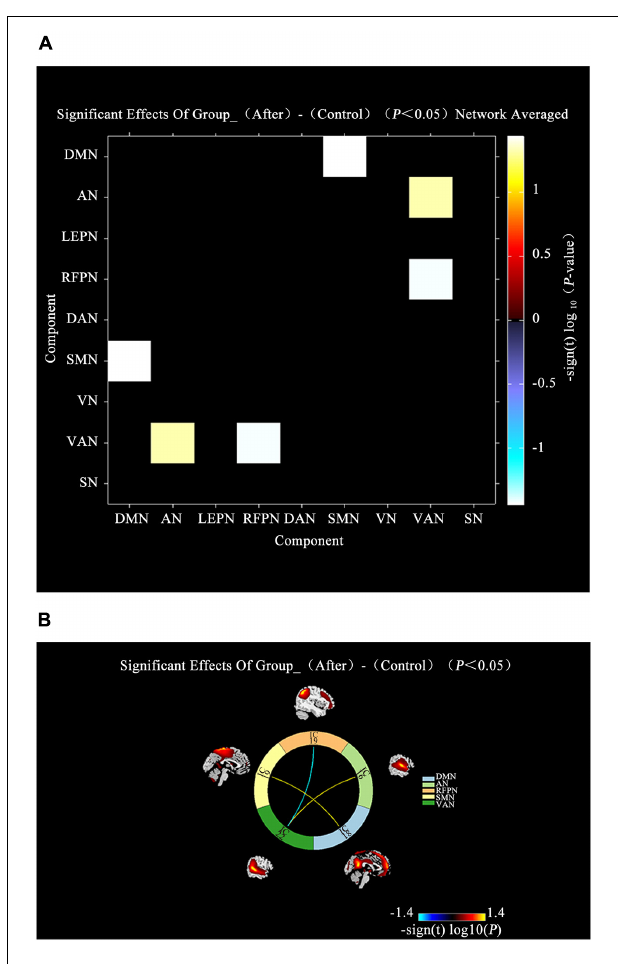
FIGURE 4 | Connectivity comparisons of large-scale network between the IBS-D patients with HCs. (A) Connectivity matrix of functional network connectivity of large-scale network in IBS-D patients after acupuncture and HCs. (B) Connectivity of functional network connectivity of large-scale network in IBS-D patients after acupuncture and HCs; Hot colors represent positive functional network connectivity, and cool colors represent negative functional connectivity. LFPN, left frontoparietal Network; DMN, anterior default mode network; SN, salience network; VAN, ventral attention network; AN, auditory network; VN, visual network; SMN, sensorimotor network; DAN, dorsal attention network; RFPN, right frontoparietal network; L, left; R,